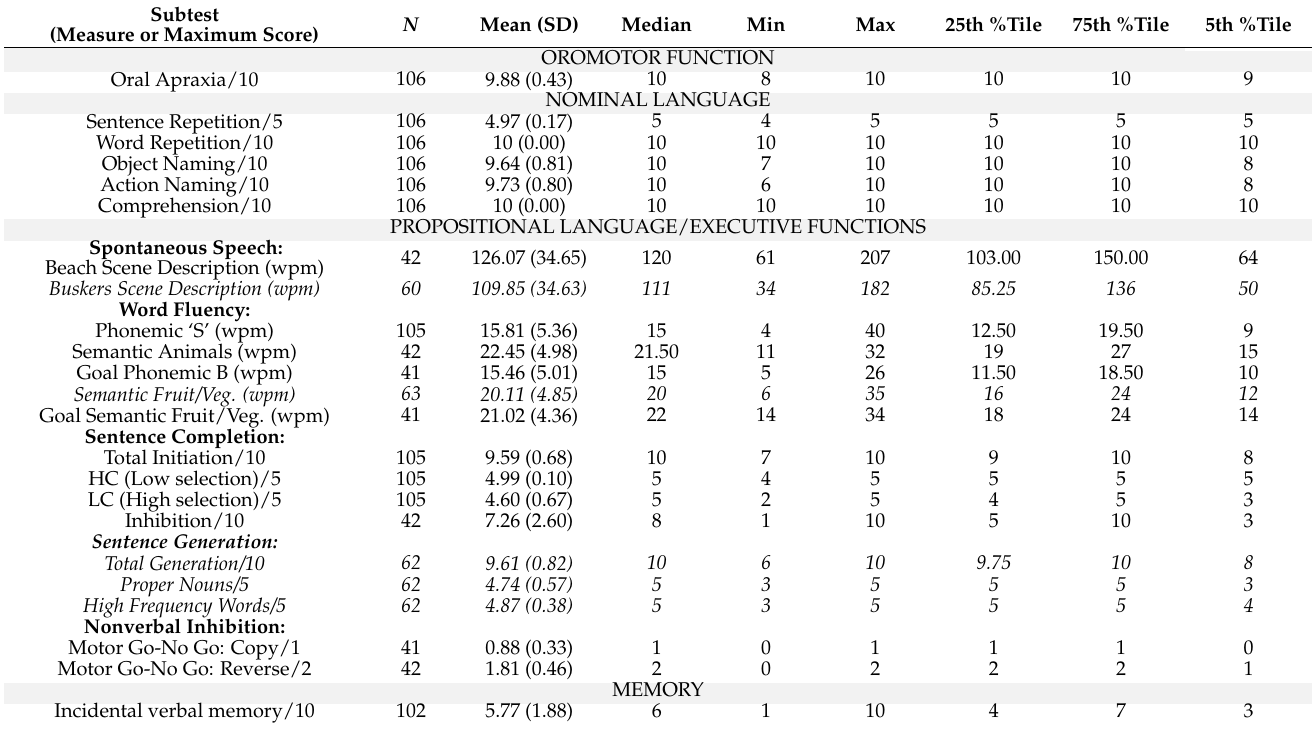
Table 2. Normative Data and 5th Percentile Cut Off Scores for Impairment for BELS Subtests. Subtest (Measure or Maximum